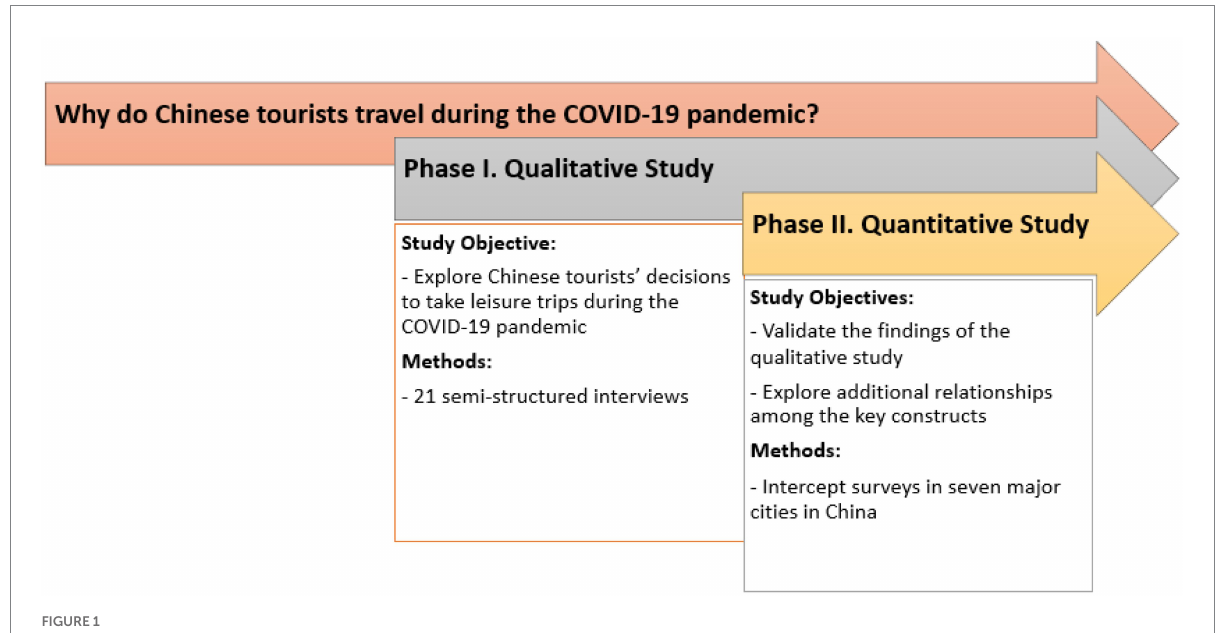
FIGURE 1 Research